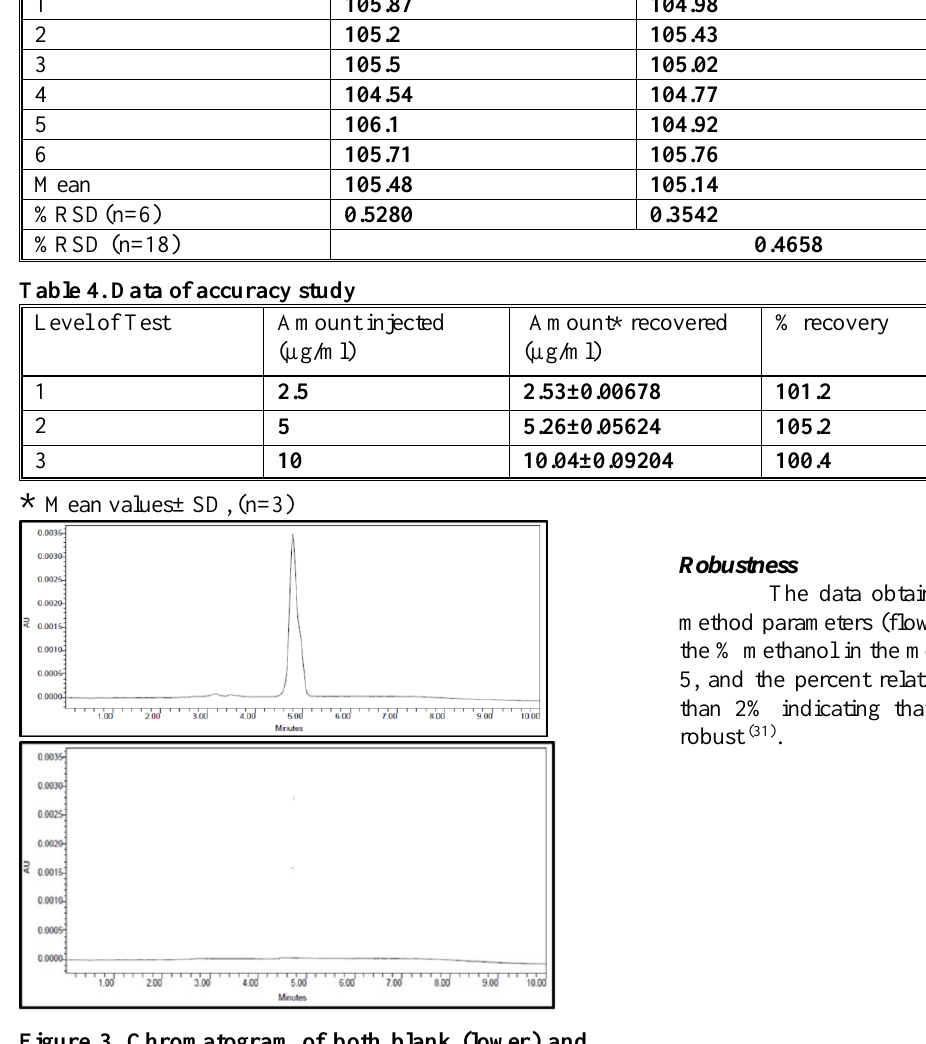
Figure 3. Chromatogram of both blank (lower) and Dabigatran Etexilate standard solution (upper) shows its retention time (chromatogram peak) at a concentration of